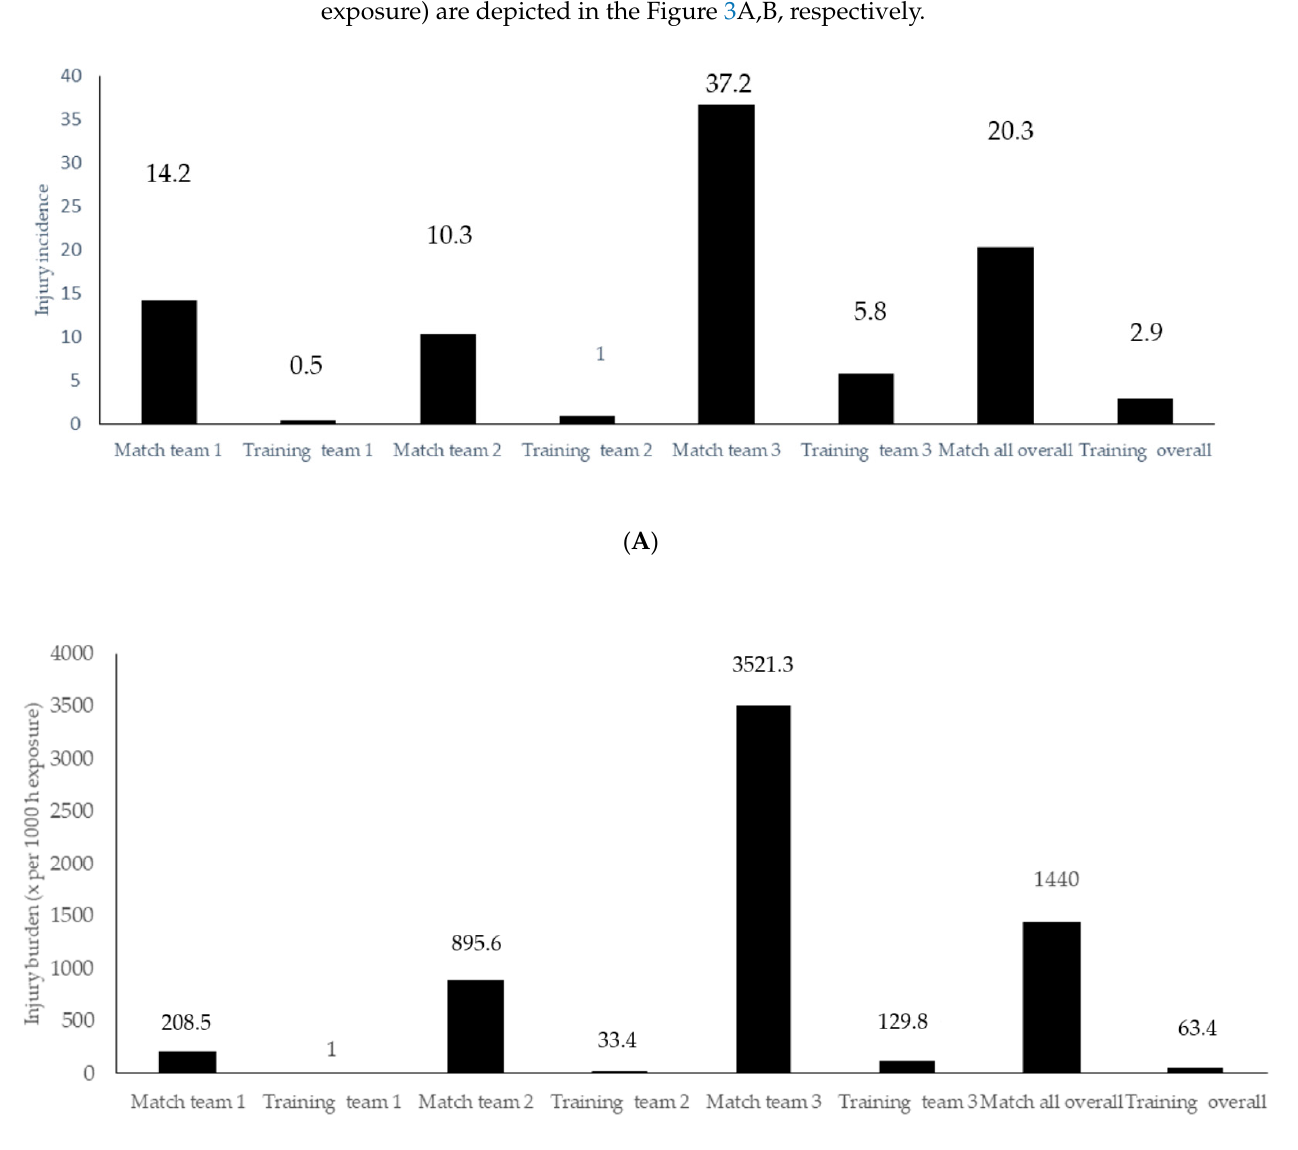
Figure 3. Injury incidence ( A ) and burden ( B ) distribution among match and training practices (expressed x per 1000 h exposure).